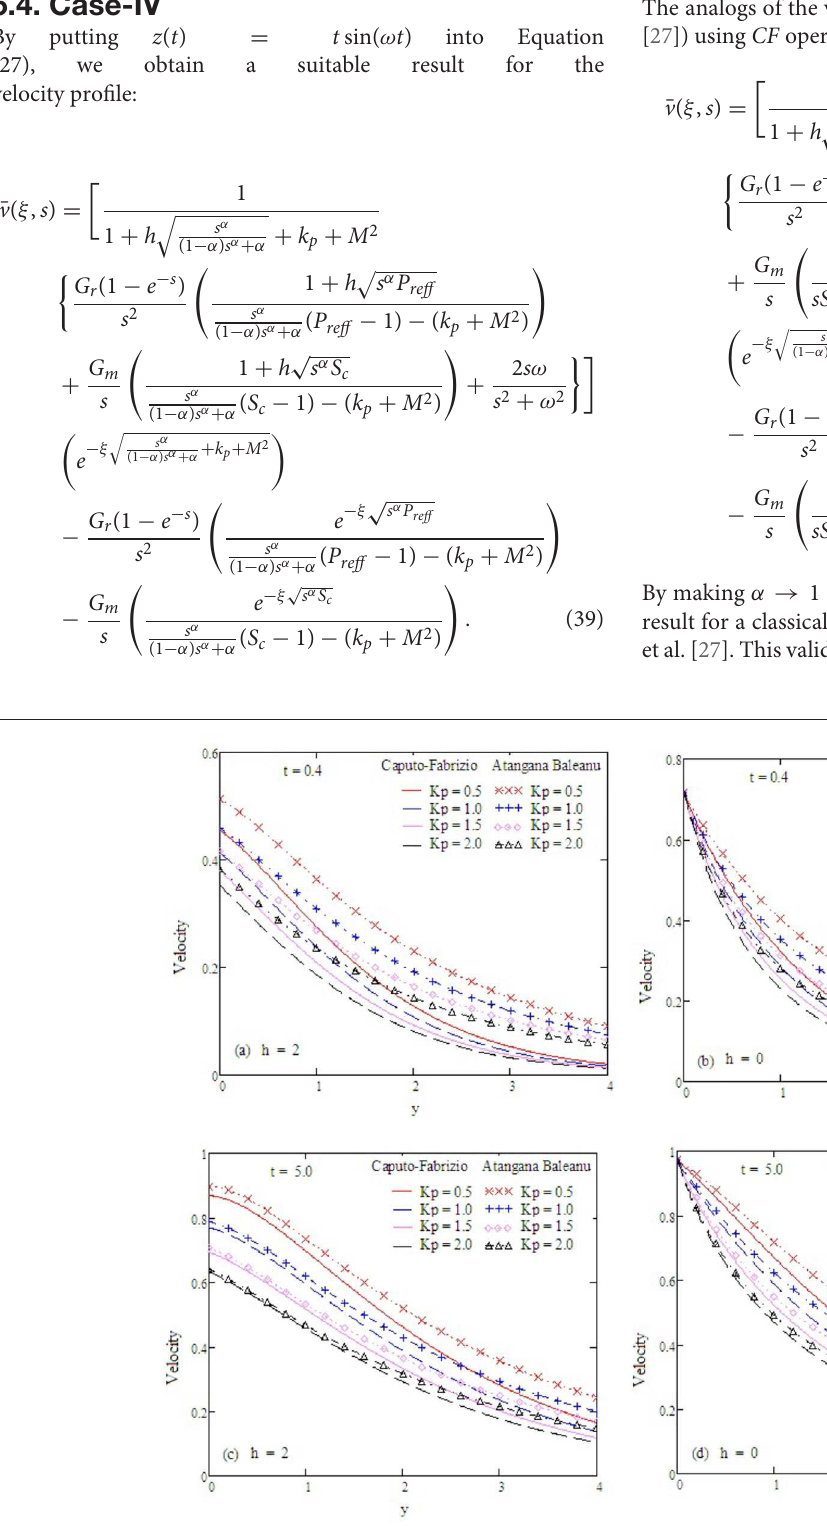
FIGURE 11 | Velocity profiles with altered values of k p and other parameters are ω